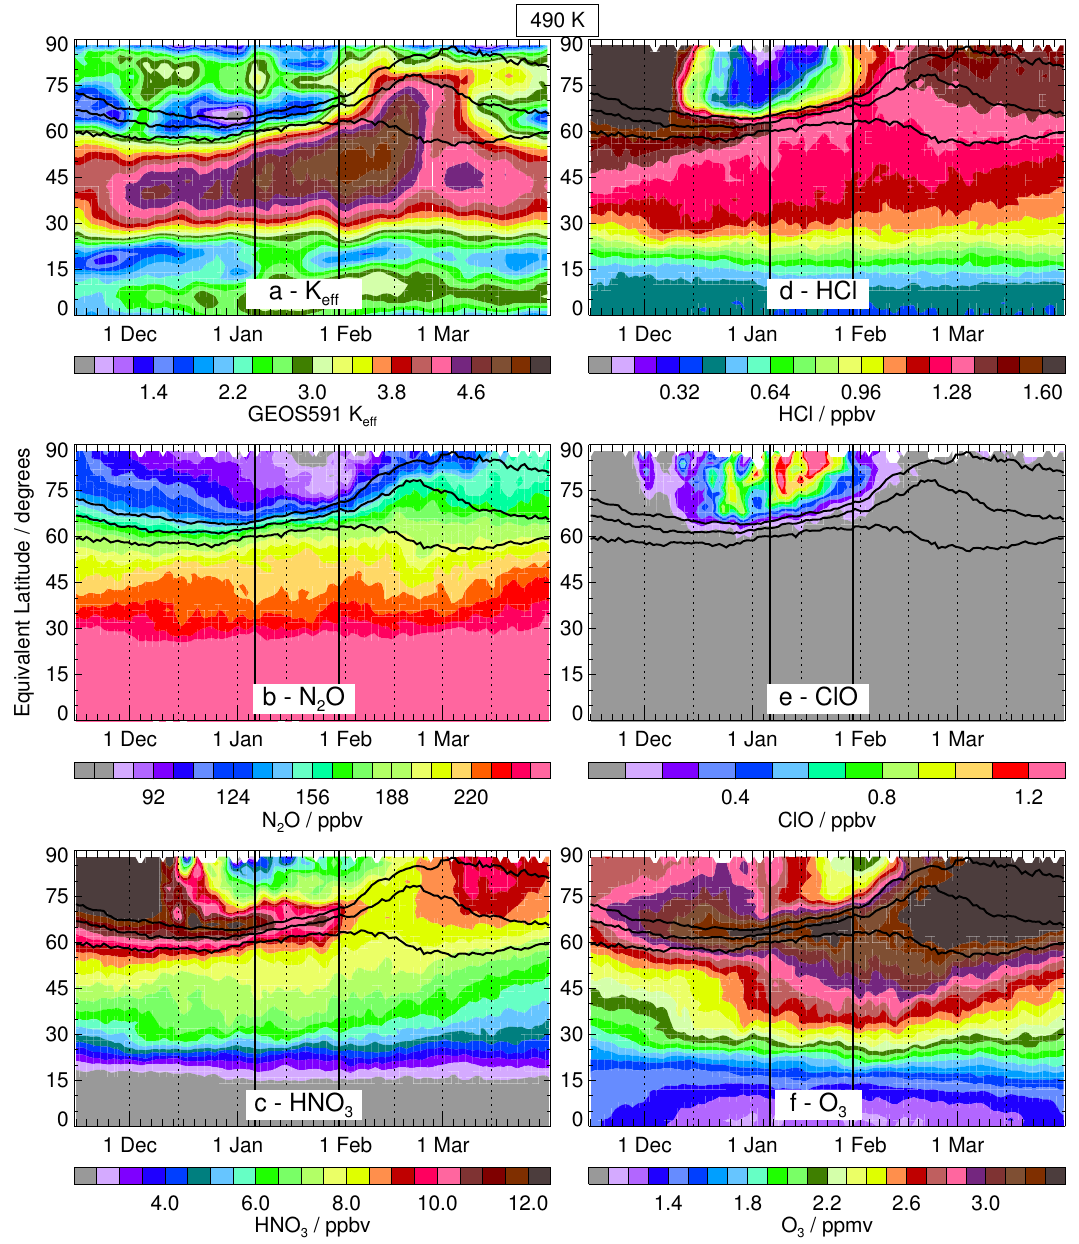
Figure 8. Equivalent latitude/time series at 490K of (a) effective diffusivity from GEOS-5.9.1 (color bar range 0.6 to 5.4, expressed as log-normalized equivalent length; low values indicate transport barriers and high values regions of enhanced mixing) and MLS (b) N 2 O (color bar range 60 to 252ppbv), (c) HNO 3 (color bar range 2.0 to 12.5ppbv), (d) HCl (color bar range 0 to 1.68ppbv), (e) ClO (color bar range 0 to 1.3ppbv), and (f) O 3 (color bar range 1.0 to 3.4ppmv). Black contours show sPV values of 1.2, 1.4, and 1 . 6 × 10 − 4 s − 1 in the vortex edge region. The thin solid black vertical lines indicate the onset day of the SSW (6 January, ∼ 2 days before the vortex split) and the day when the offspring vortices reunited (30